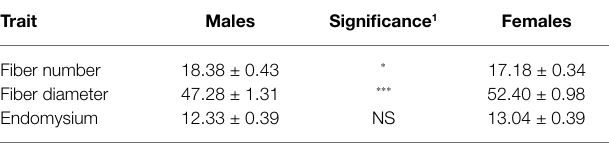
TABLE 3 | Sex effects at day 56 between males and females for histological analysis (Mean ± SE). Trait